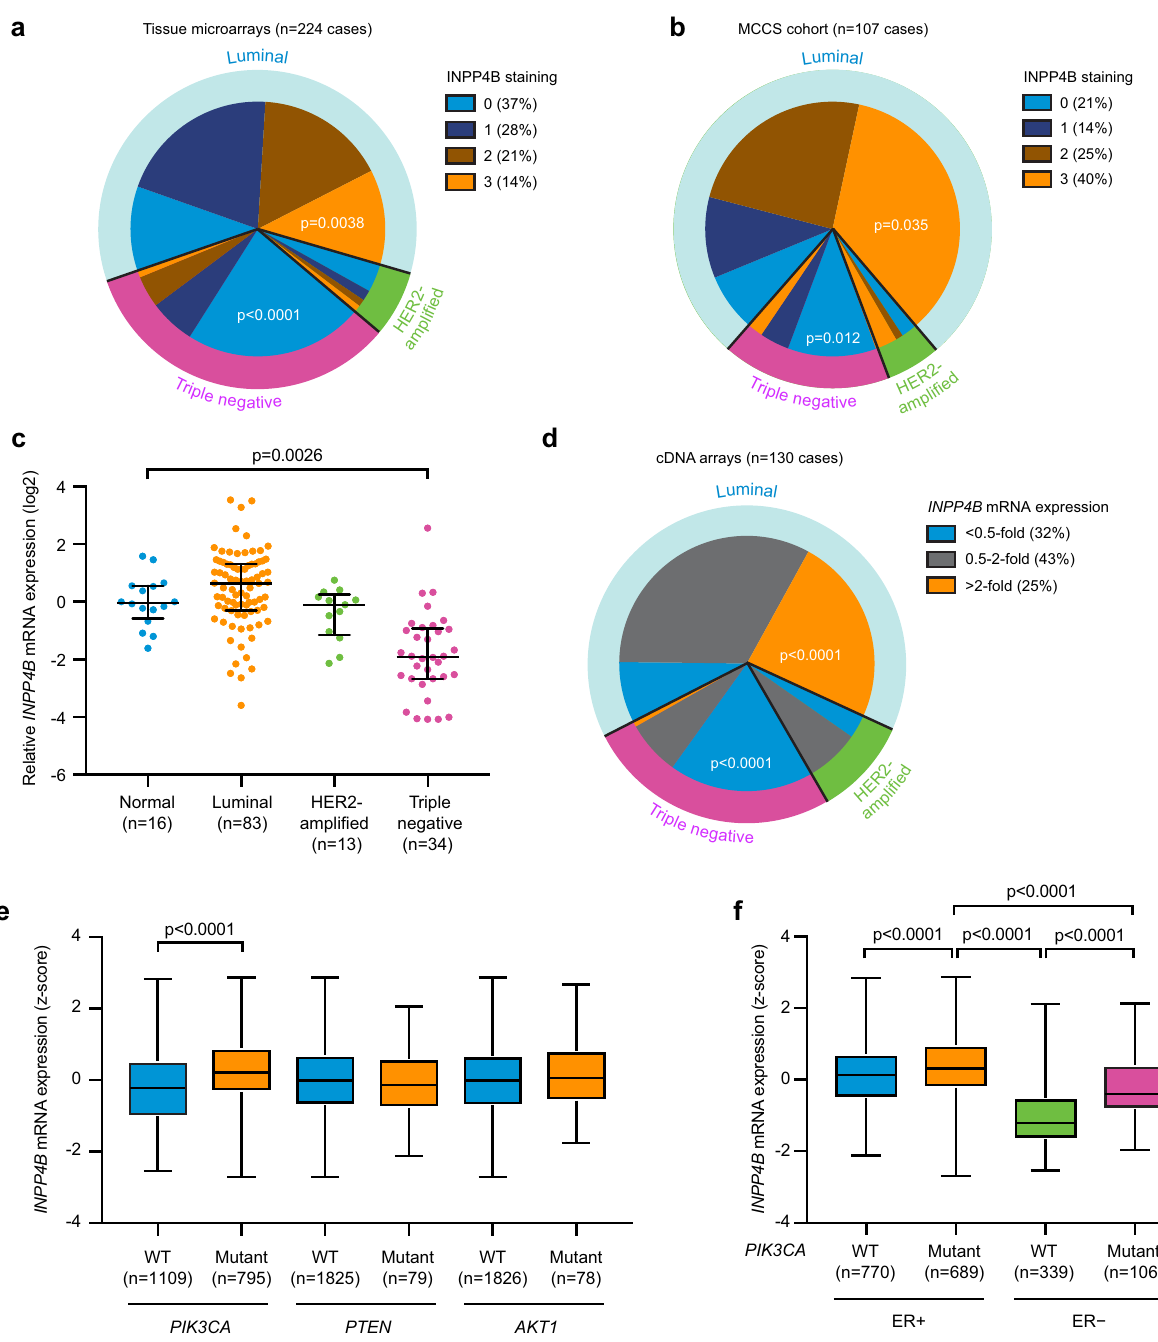
Fig. 1 INPP4B expression is increased in PIK3CA -mutant ER + breast cancers. a , b Primary human breast cancer tissues and normal adjacent breast tissues from tissue microarrays (US Biomax, n = 224 cases) ( a ) or the Melbourne Collaborative Cohort Study (MCCS, n = 107 cases) ( b ) were immunostained using an INPP4B-speci fi c monoclonal antibody. INPP4B protein expression was scored as 0 (no expression), 1 (low), 2 (moderate), and 3 (high), and correlated with breast cancer subtype. c , d Relative INPP4B mRNA expression was quanti fi ed from normal adjacent breast and primary breast cancer tissue samples using Tissue Scan Breast Cancer cDNA Arrays I-IV (OriGene) by quantitative RT-PCR using INPP4B primers ( n = 130 cases). INPP4B mRNA expression was normalized to β -ACTIN expression levels and quanti fi ed relative to the mean of the normal adjacent breast samples. c Data represent median INPP4B mRNA expression ±25th and 75th percentiles. d Altered INPP4B mRNA expression was correlated with breast cancer subtype. e , f INPP4B mRNA expression was strati fi ed by PIK3CA , PTEN , or AKT1 mutation status ( e ), or PIK3CA mutation status and ER-positivity ( f ) in breast tumors from the METABRIC cohort ( n = 1904 cases). The center line indicates the median, the lower bound of the box indicates the 25th percentile, the upper bound of the box represent the 75th percentile, the lower whisker extends from the 25th percentile to the minimum value, and the upper whisker extends from the 75th percentile to the maximum value. p values determined by Fisher ’ s exact test are indicated in a , b , d , by Kruskal – Wallis test with Dunn ’ s post hoc test in c , f , and by two-tailed unpaired Mann – Whitney test in e